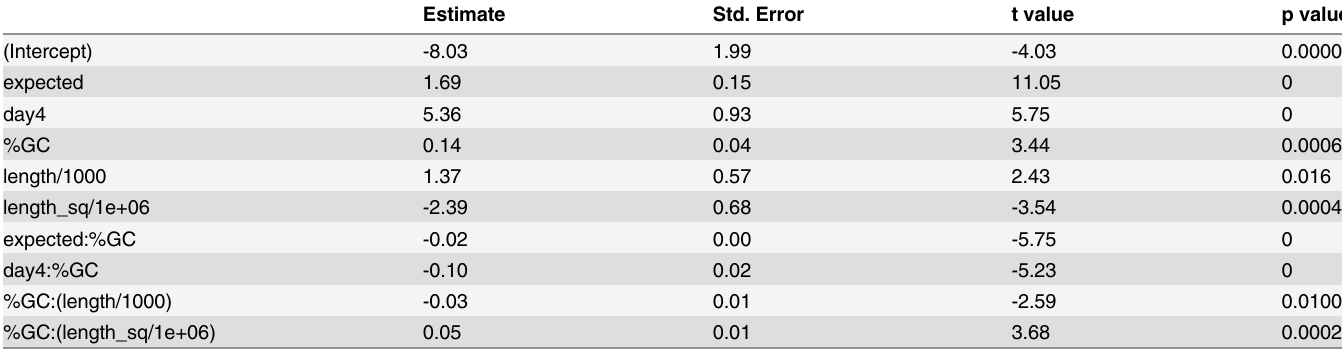
attributes to the model. Similar results were obtained with the CQN normalized RSEM values (S5 Table, S5 Fig).